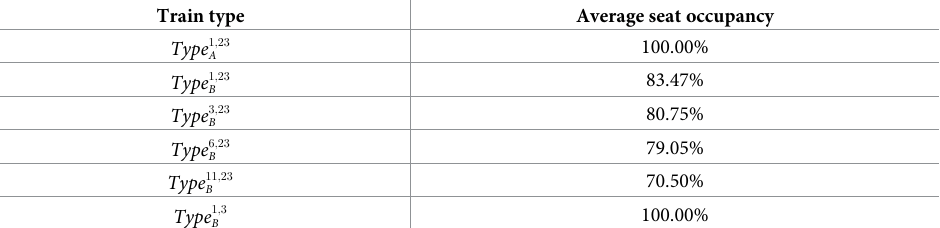
Table 10. The average seat occupancy of each train type.